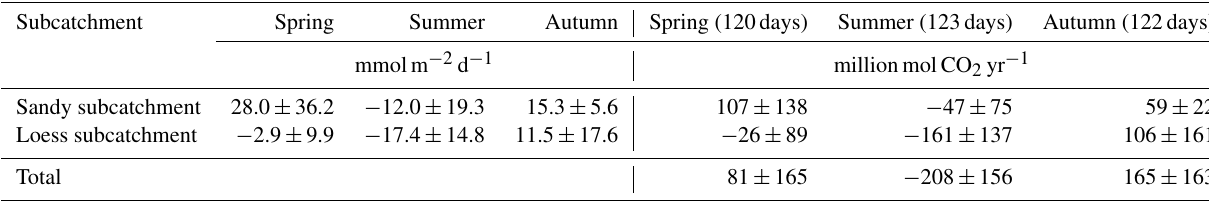
Table 1. CO 2 emissions from 337 check-dam-formed reservoirs within the Wuding River catchment ( ± 1SD). Subcatchment